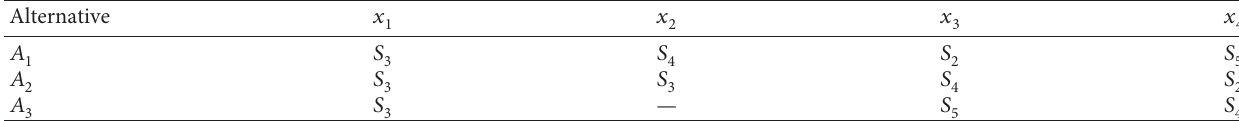
Table 25: The linguistic decision matrix provided by the fifth DM.